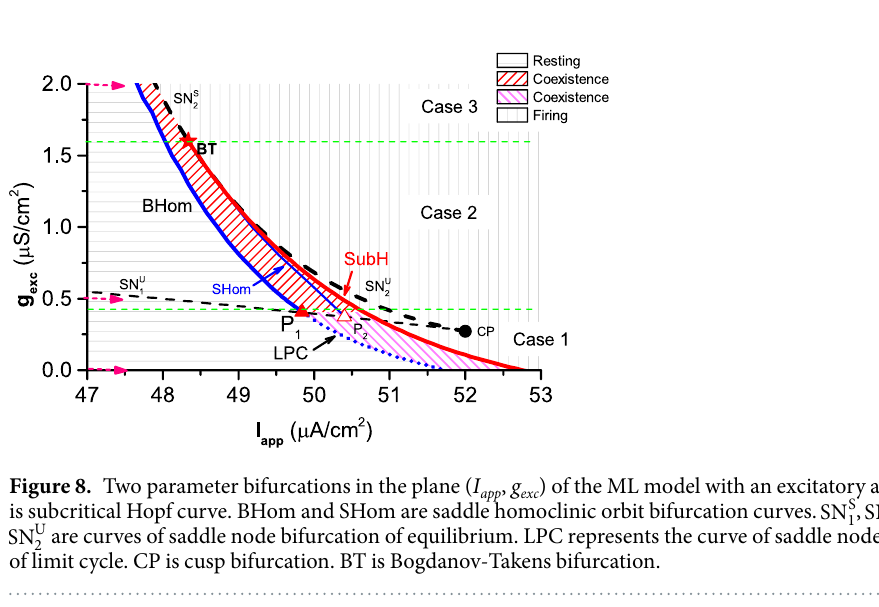
Figure 7. Steady state I–V curves. ( a ) g exc = 0.0 μ S/cm 2 ; ( b ) g exc = 0.5 μ S/cm 2 ; ( c ) g exc = 2.0 μ S/cm 2 . SubH represents subcritical Hopf bifurcation. BHom represents saddle homoclinic orbit bifurcation. SN 2S represents saddle node bifurcation of equilibrium.